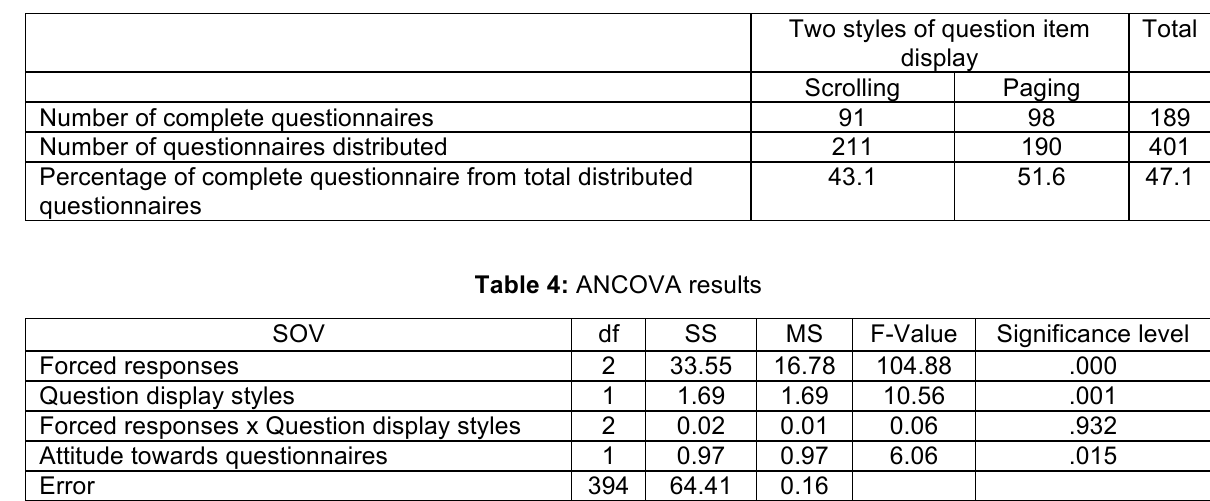
Table 3: Survey responses categorized by two styles of question display